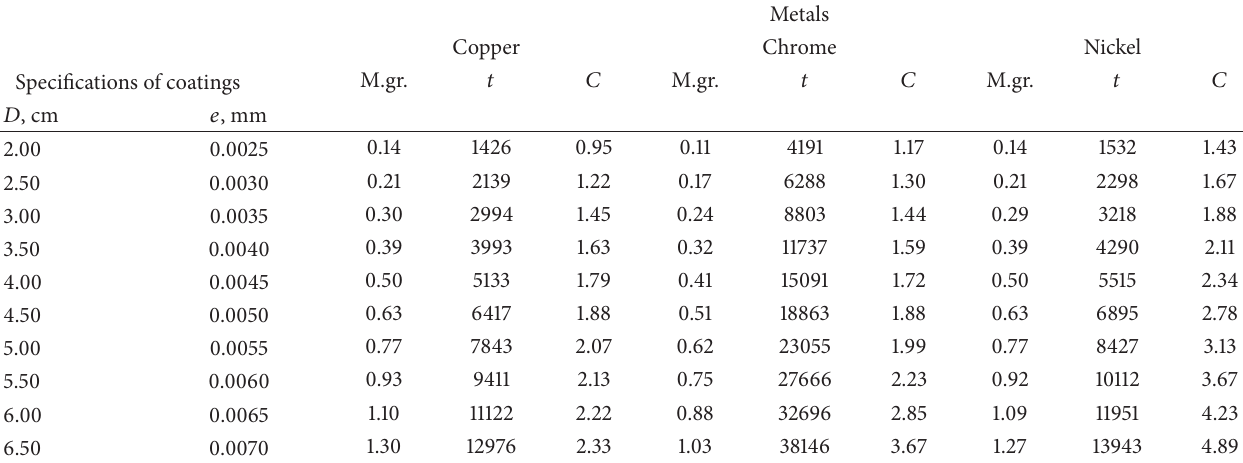
Table 4: Correlation of costs, manufacturing process, and time of deposition